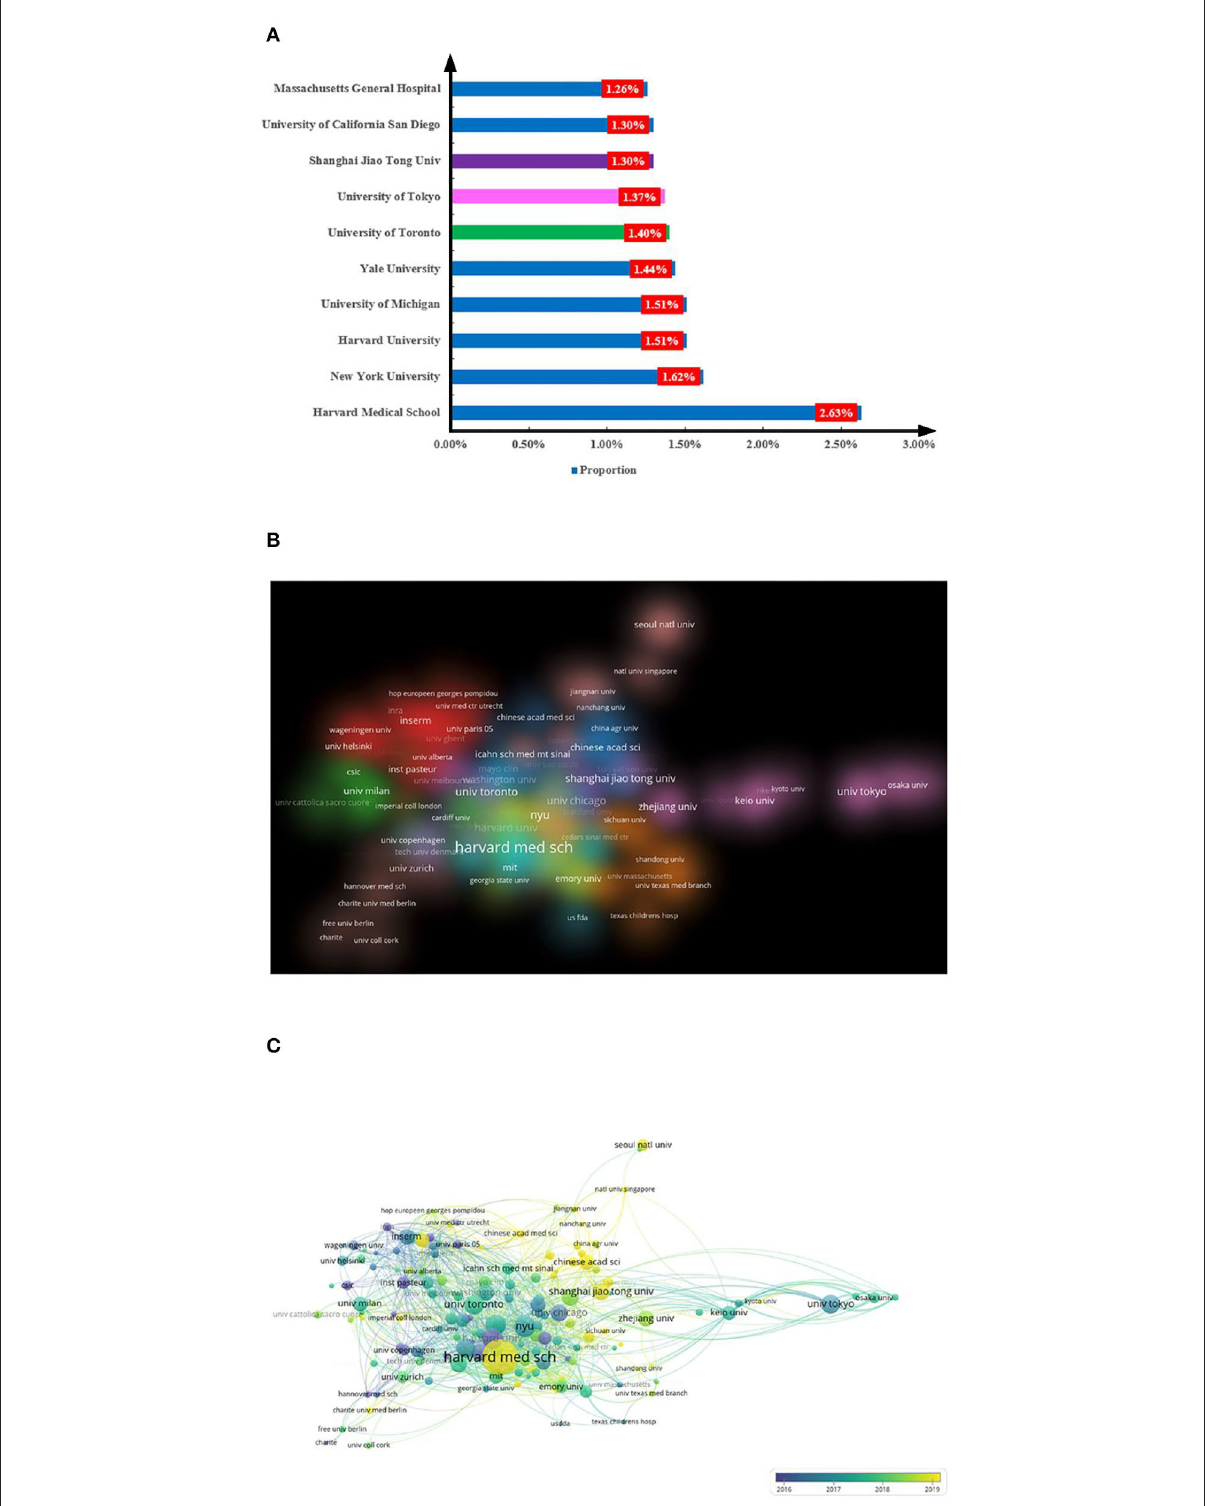
FIGURE5 Distribution of institutions engaged in research gut microbiota and host immune response. (A) Top 10 institutions by number of publications. Numbers represent the percentage of publications, and different colors represent different countries. (B,C) Network of institutions visualized in VOSviewer; the size of circles reveals the number of